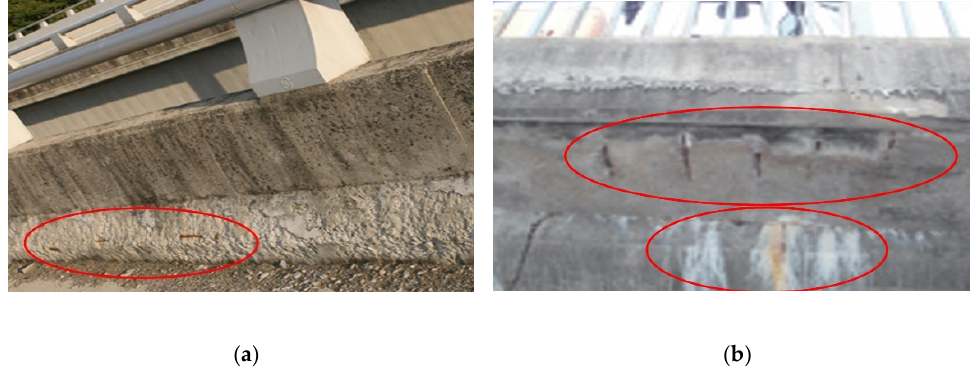
Figure 2. Deterioration factors of waterproofing materials for bridges and deterioration of structures; ( a ) corrosion of concrete rebar due to leakage, ( b ) deterioration of bridge structures due to influent water.